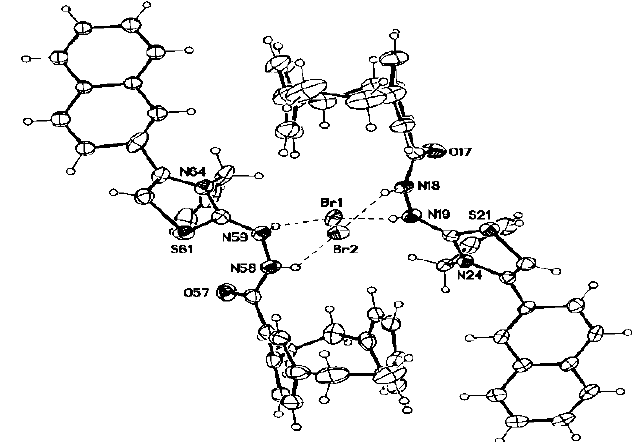
Figure 3. Molecular structure of the dimer of compound 8c identified according to